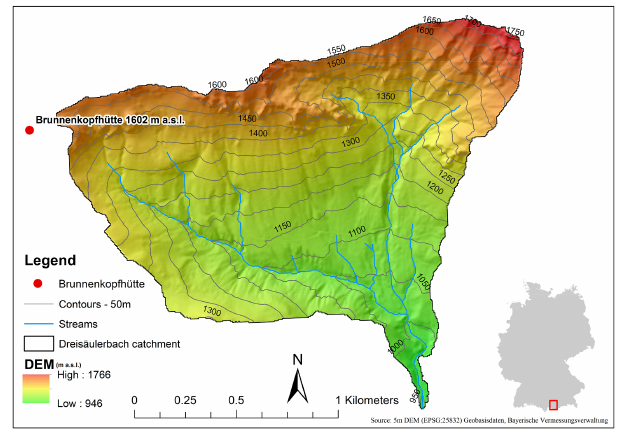
Figure 1. Location of the Brunnenkopfhütte automatic snow and weather station in the Dreisäulerbach catchment – German